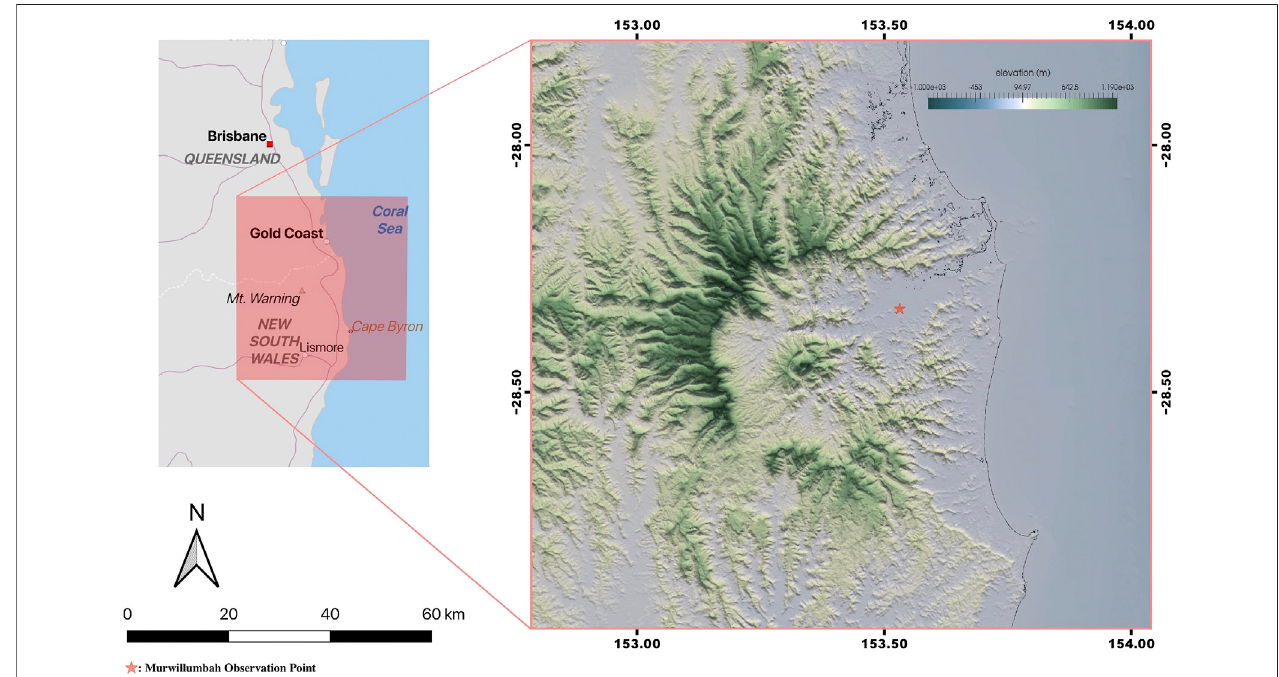
FIGURE1| Mapsofthestudiedregion(CreatedusingNaturalEarthdatainQGIS).OverviewofthestudysitelocationinAustraliaandazoomedinelevationmapof the study site. y lat-min: ∼ – 28 ° , y lat-max: ∼ – 29 ° , x lon-min: ∼ 153.5 ° , and x lon-max: ∼ 153 ° .